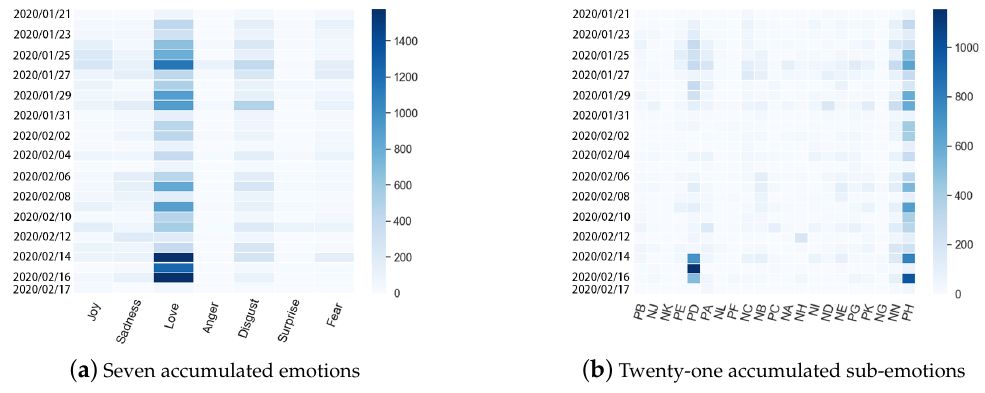
Figure 5. Public accumulated emotions from 21 January 2020 to 17 February 2020.